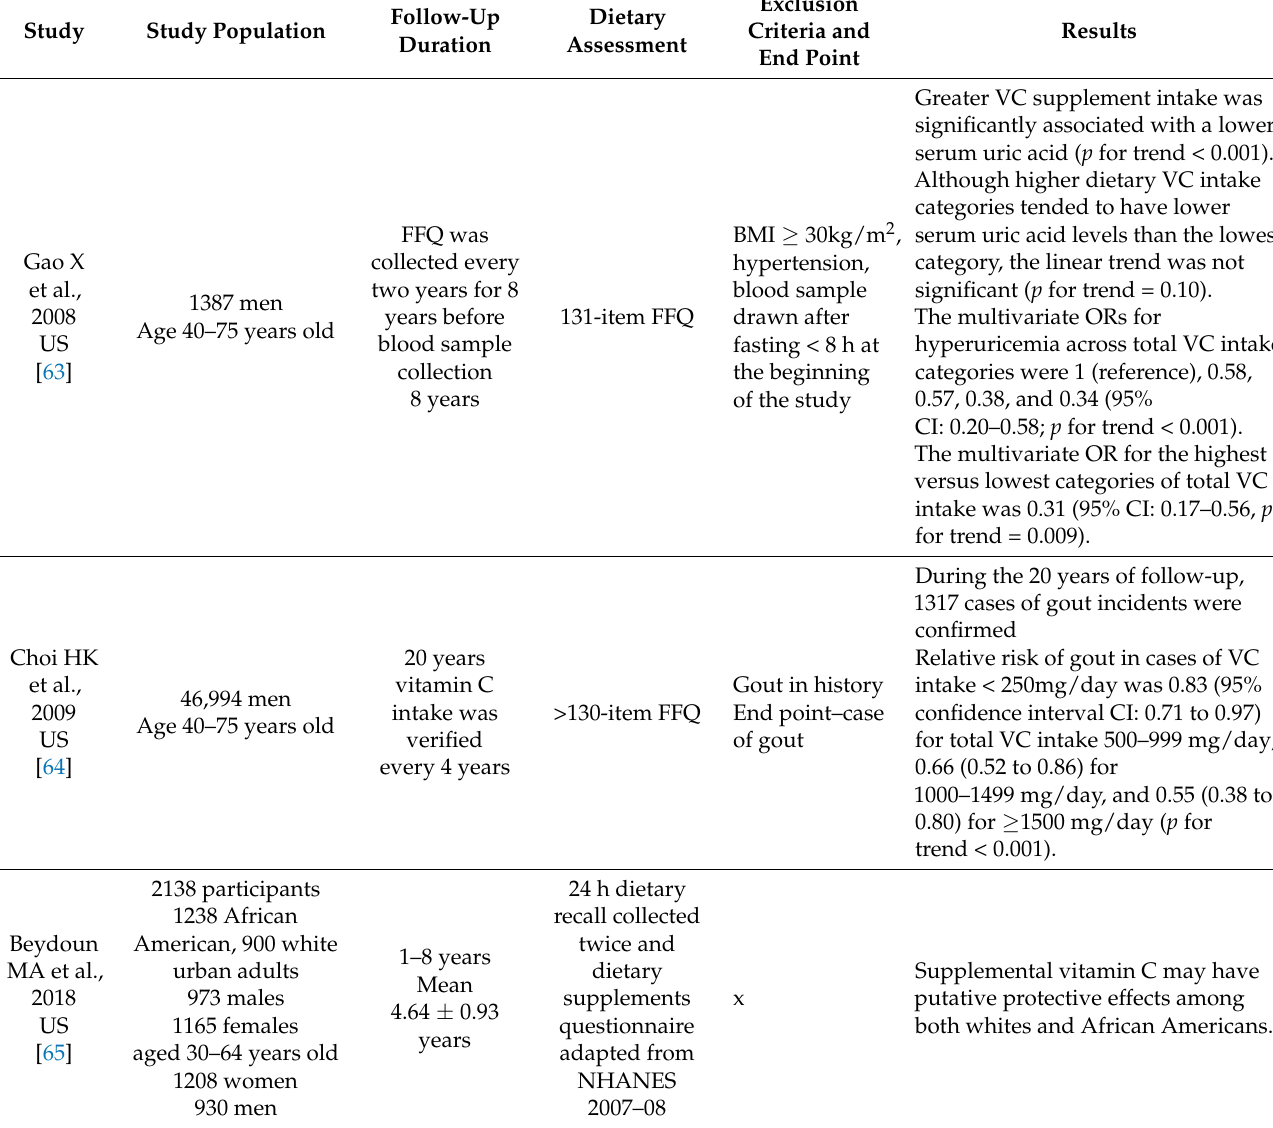
Table 2. Longitudinal studies discussing the dependence of vitamin C intake in the diet and the risk of hyperuricemia.